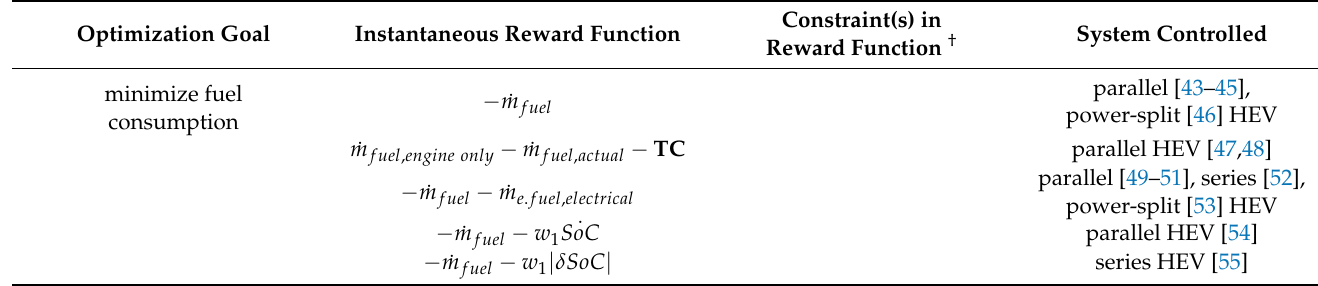
Table 3. Reward functions used in single objective RL-based powertrain control